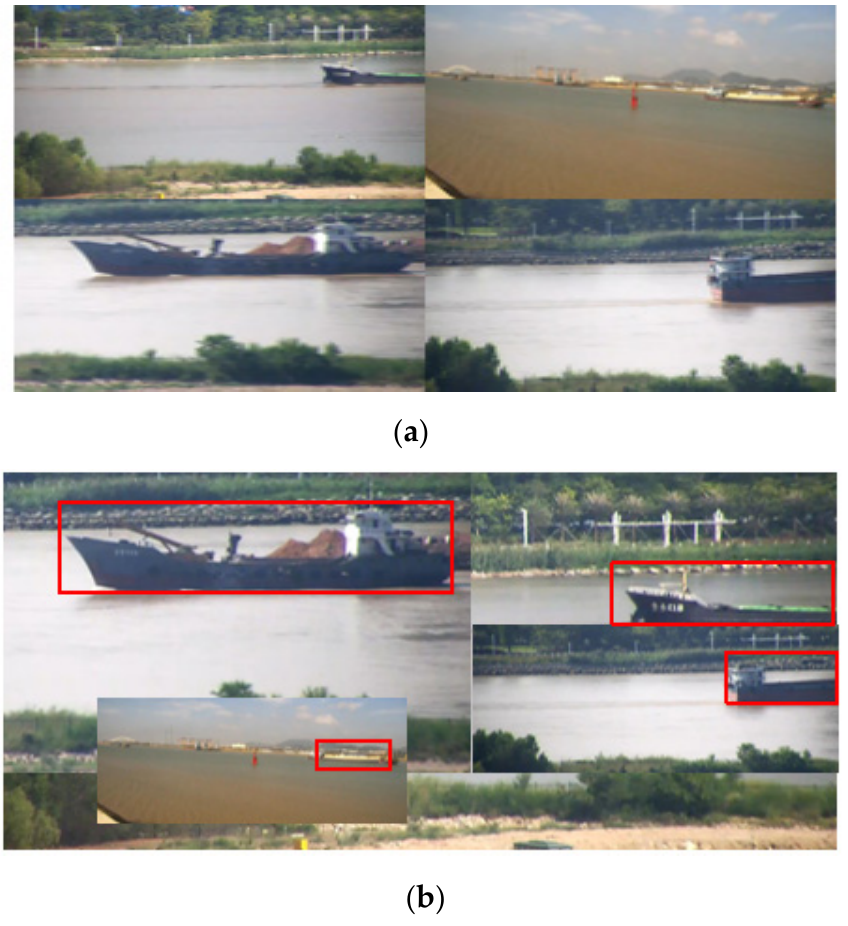
Figure 5. Mosaic data enhancement effect: ( a ) original picture; ( b ) mosaic data enhancement.